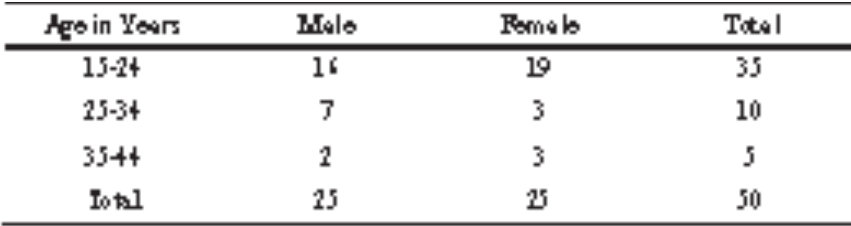
Table I : Age and Sex Distribution (n=50)